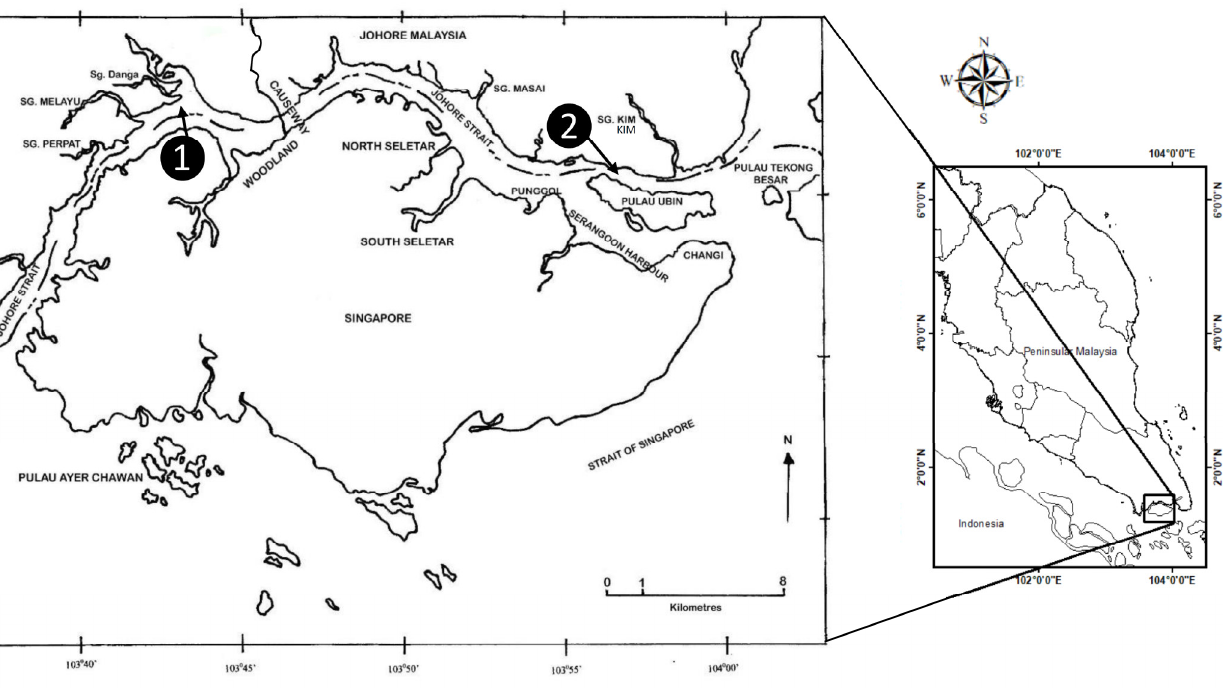
Figure 1. Transplantation sites of mussels at Kampung Sungai Melayu ( ❶ ) and Kampung Pasir Puteh ( ❷ ) in the Straits of Johore from the present study.